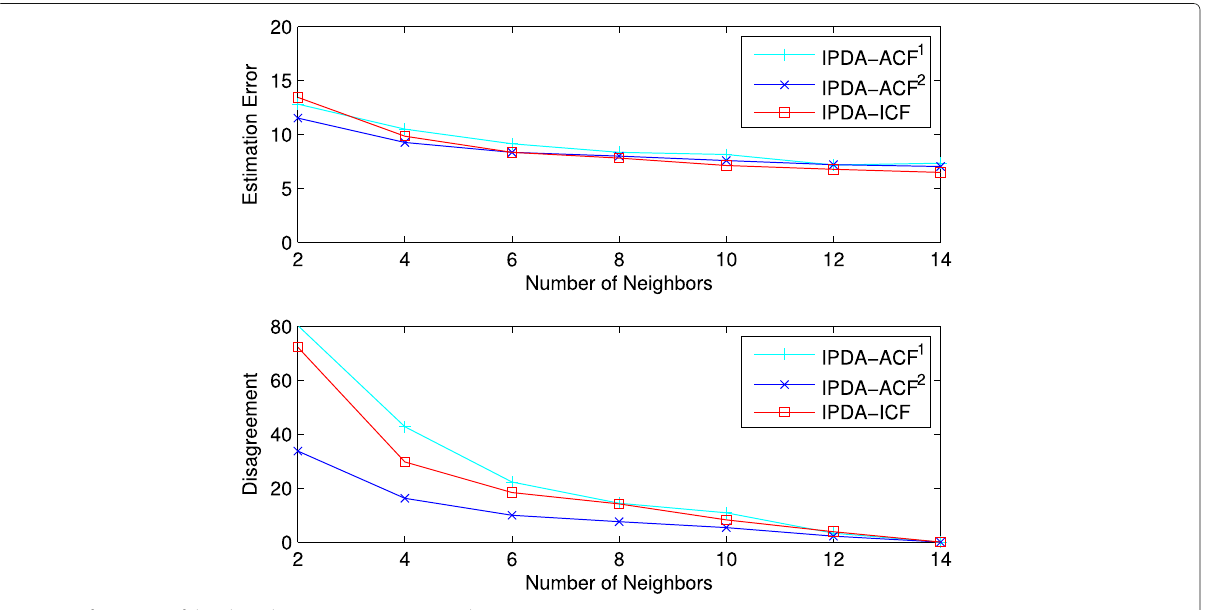
Fig. 6 Performance of the algorithms at t = 40 vs. network connectivity